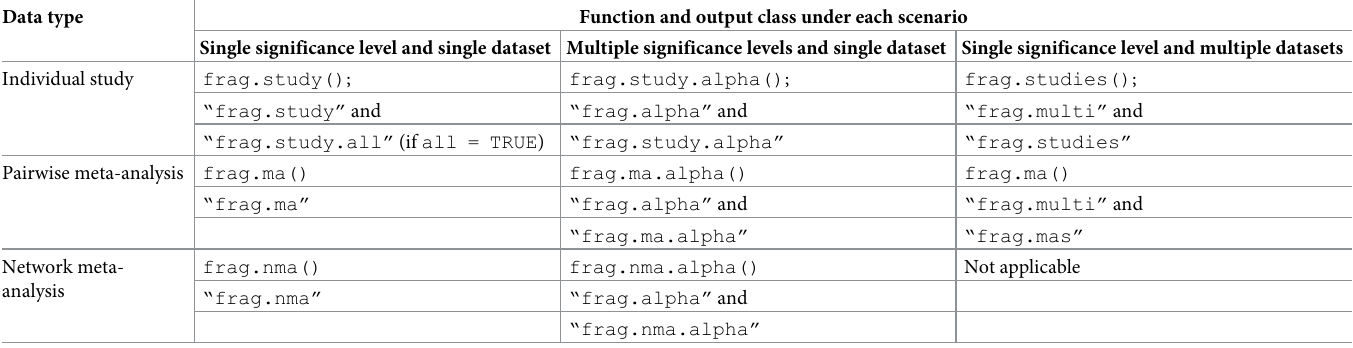
Table 2. Summary of major functions (followed by parentheses) and their output classes (within quotation marks) in the package “fragility” for assessing the fragil- ity of different data types. Data